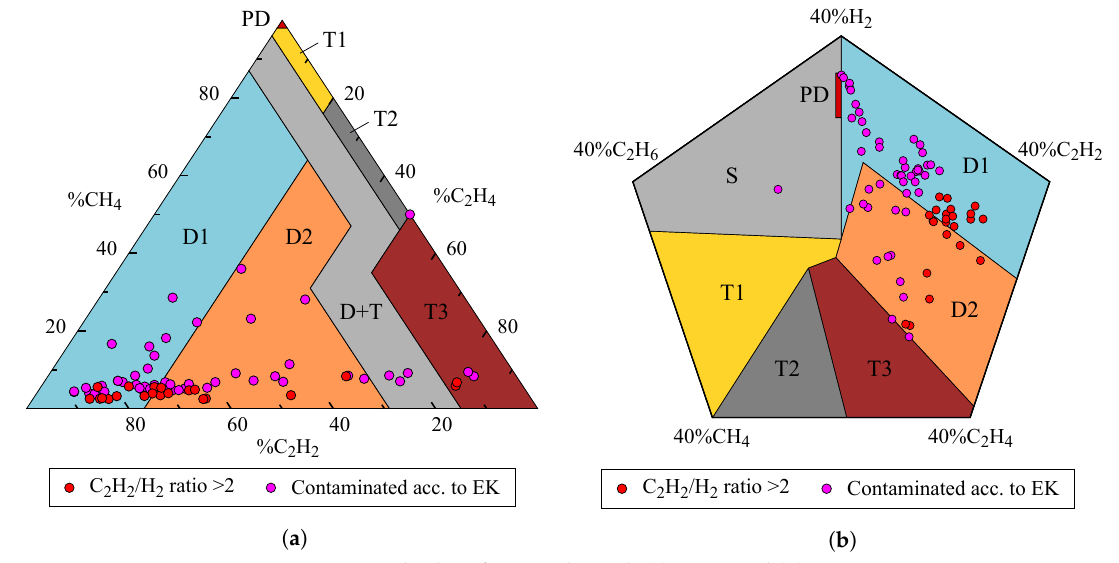
Figure 9. Fault identification through ( a ) DTM and ( b ) DPM.